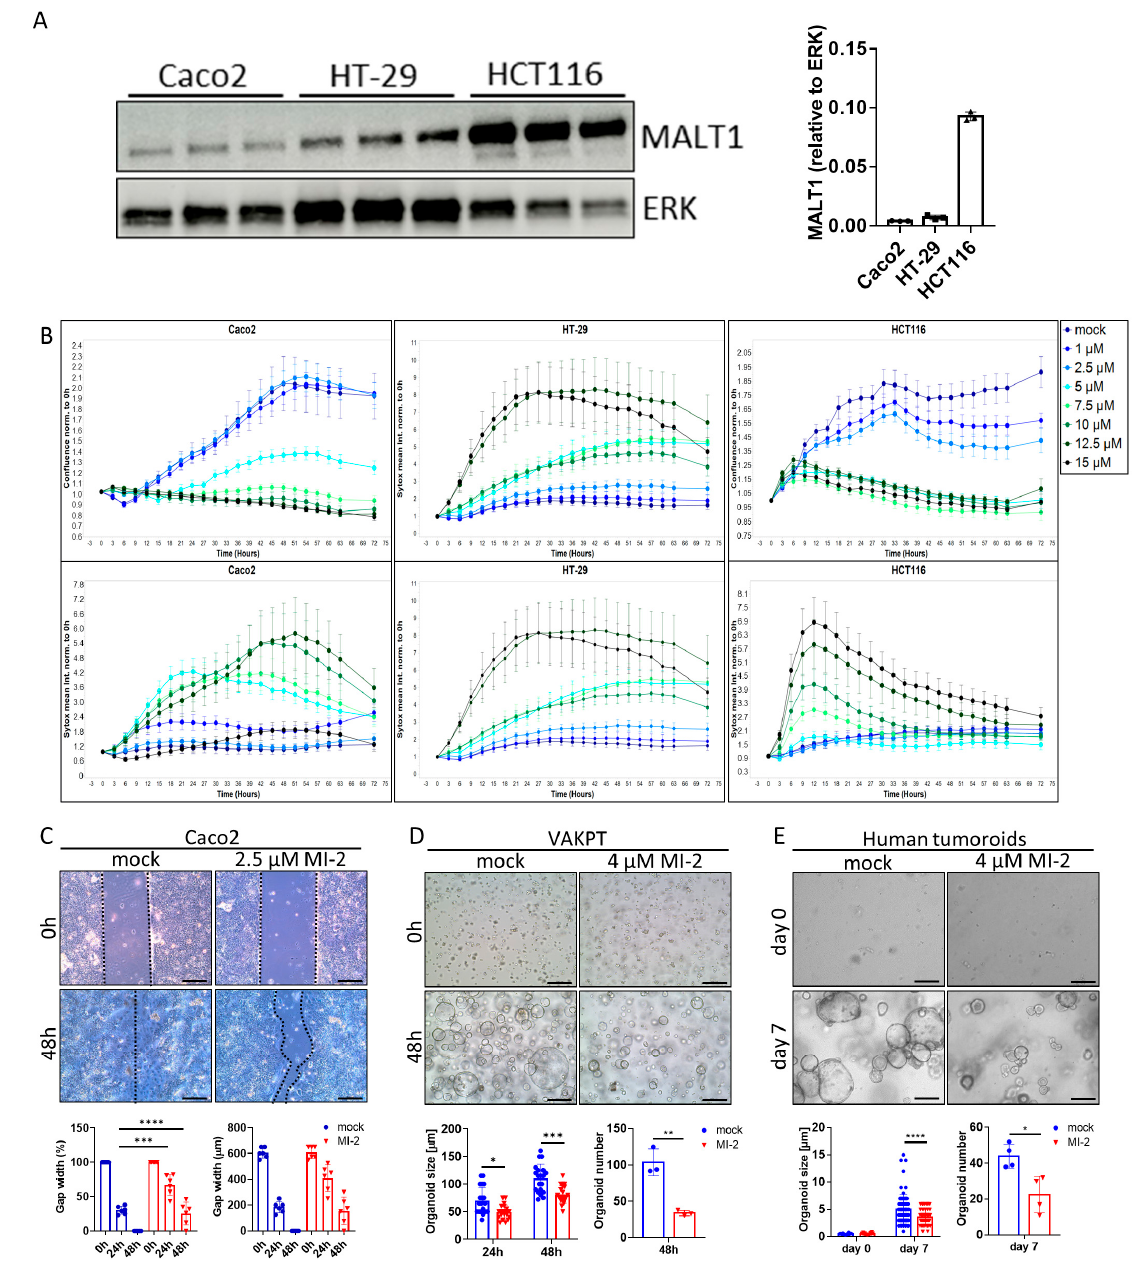
Figure 3. MALT1 proteolytic activity controls cell proliferation and viability. ( A ) Western blot analysis and protein volume quantification of MALT1 protein levels in Caco2, HT-29 and HCT116 cells. ERK was used as a loading control. ( B ) Live cell analysis of Caco2, HT-29 and HCT116 cells stimulated with indicated MI-2 concentrations. Cell confluence (upper panel) and Sytox orange intensity (lower panel) indicate cell growth and cell death over time (hours). ( C ) Scratch assay of Caco2 cells stimulated with 2.5 µM MI-2. Cell growth was monitored for 48 h, gap width was measured every 24 h for quantification (scale bar: 200 µm). *** p < 0.001, **** p < 0.0001 in ANOVA for multiple comparisons, error bars represent mean ± SD, 95% CI. ( D , E ) Tumor organoid formation assays using ( D ) murine tumor organoids (VAKPT) and ( E ) human tumor organoids (CRC patients). Single tumor cells were stimulated with 4 µM MI-2 and monitored over time (scale bar: 200 µm). * p < 0.05, ** p < 0.01, *** p < 0.001, **** p < 0.0001 in ANOVA for multiple comparisons and in unpaired two-tailed t -test; error bars represent mean ± SD, 95% CI.